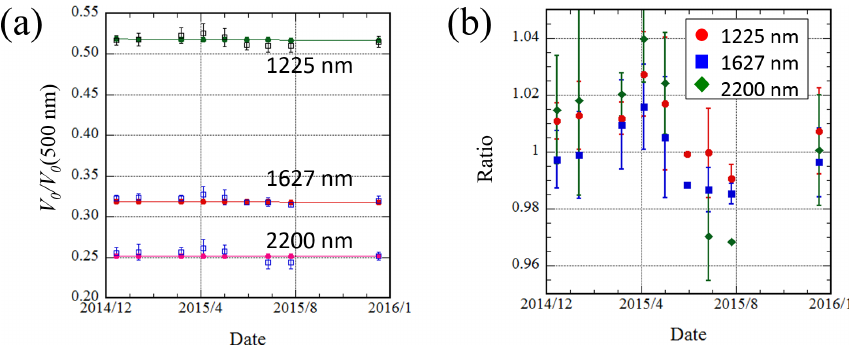
Figure 11. (a) Monthly mean of V 02 /V 01 and the standard deviation: V 01 = V 0 ( 500nm ) . (b) Ratio of V 02 to the interpolated value of the calibration constant determined by the Langley method. The red symbols are 1225nm, blue are 1627nm, and green are